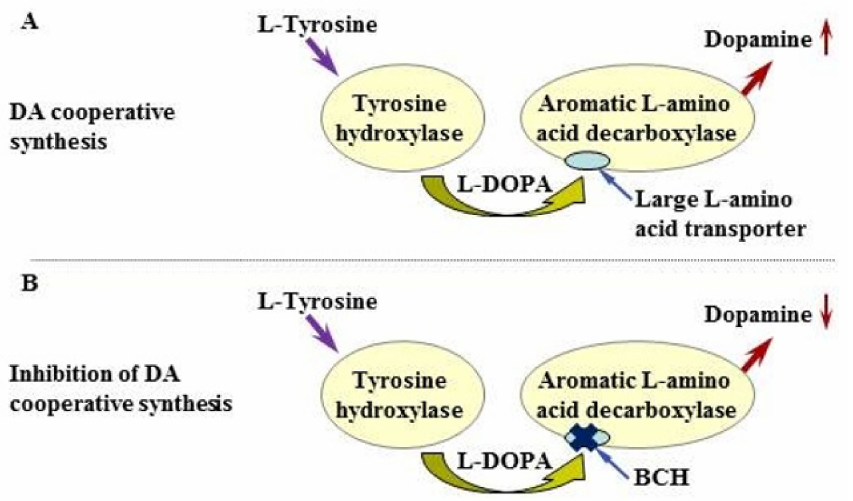
Figure 8. Schematic representation: ( A ) cooperative synthesis of dopamine (DA) by monoenzy- matic neurons containing one of the enzymes of dopamine synthesis—tyrosine hydroxylase or aromatic L-amino acid decarboxylase; ( B ) inhibition of cooperative DA synthesis by 2-amino-2- norbornanecarboxylic acid (BCH), an inhibitor of the large neutral amino acid membrane